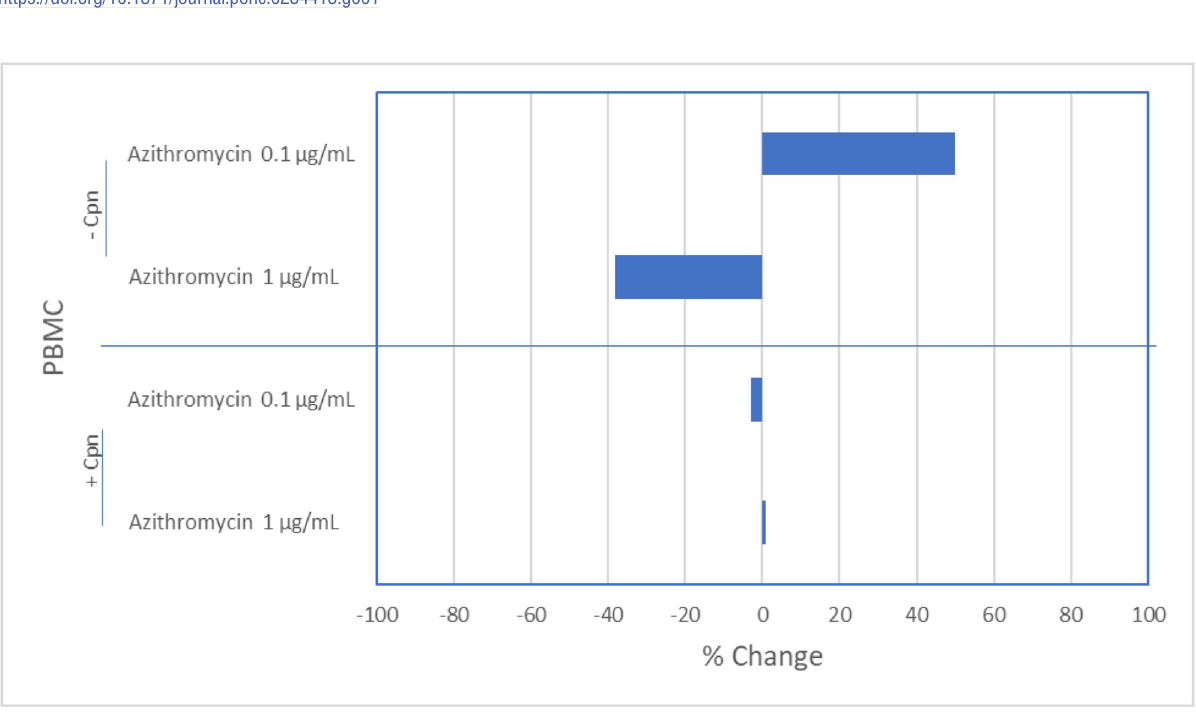
Fig 2. Effect of azithromycin on Chlamydia pneumoniae mediated IgE responses. Data represented as percent control. P > 0.05, in all cases (Mann- Whitney U Test).